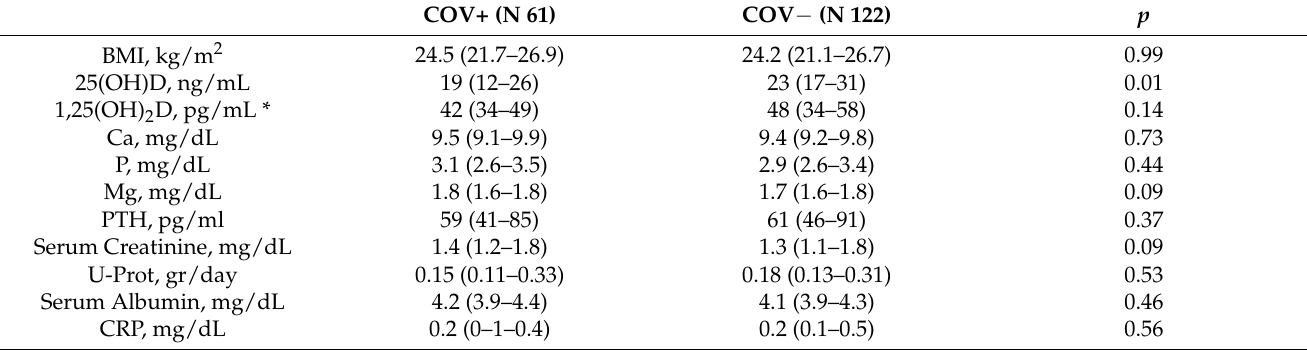
Table 2. Differences in vitamin D status and other evaluated anthropometric and biochemical parameters between COV+ and COV − in the 12 months before